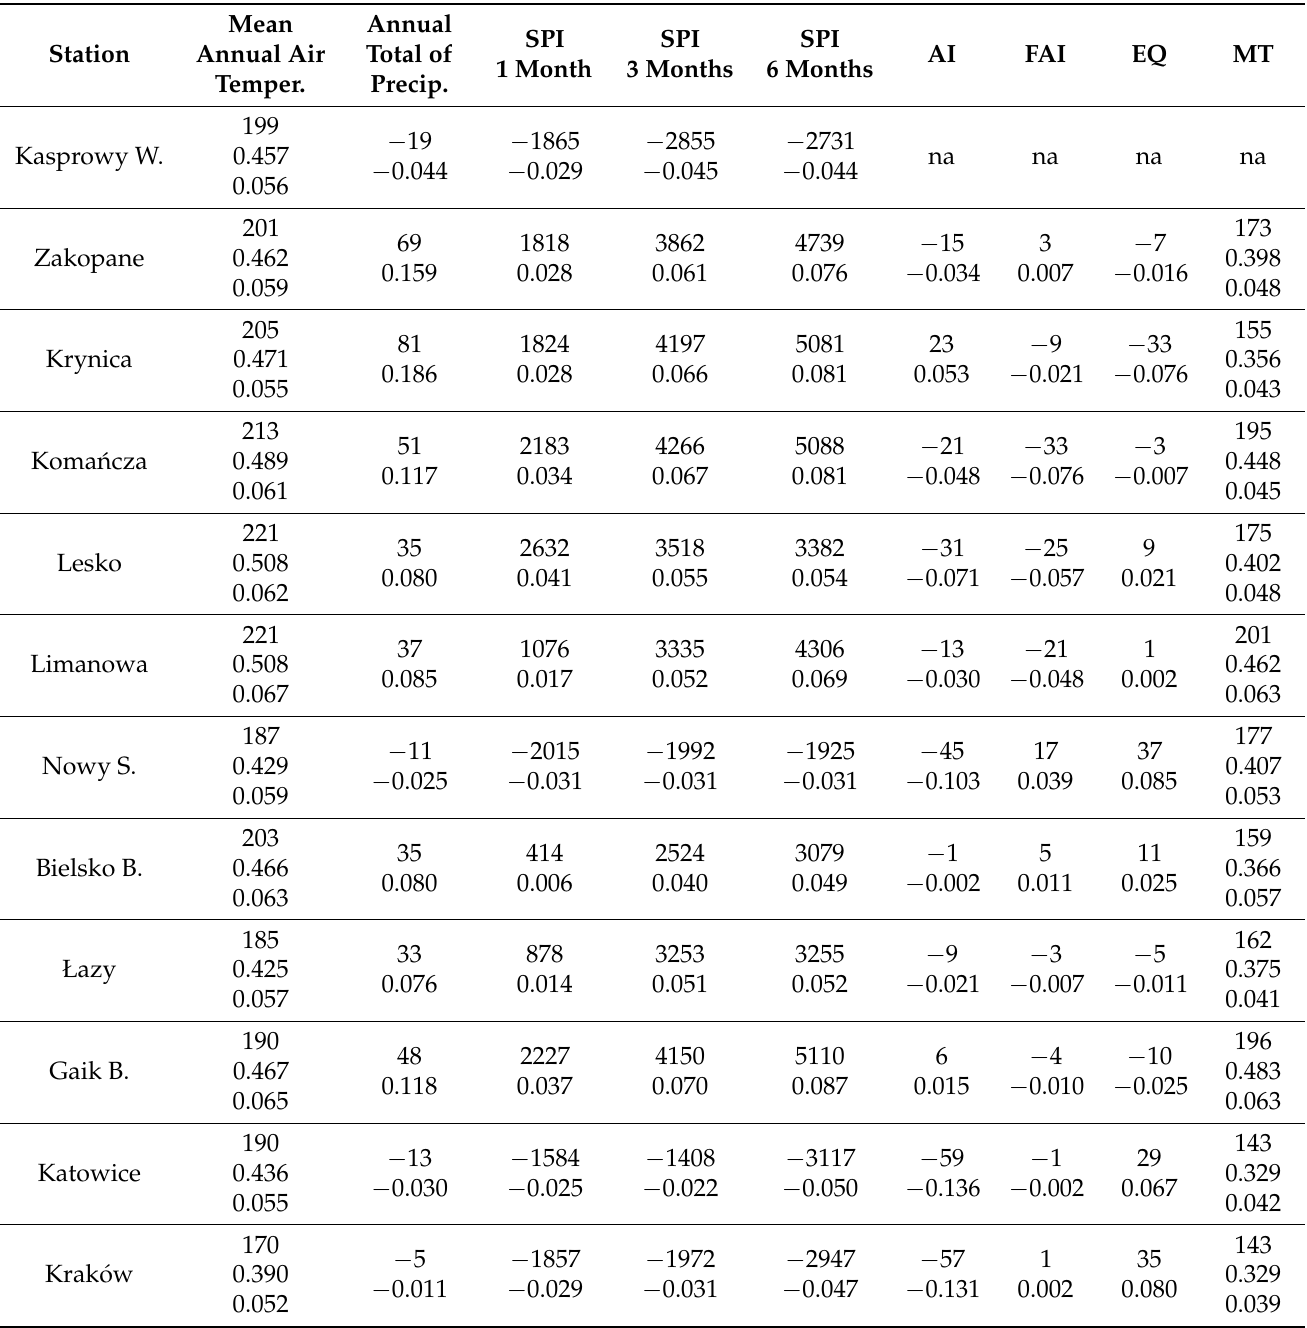
Table A1. Values of test statistics S (upper value) and tau (middle/bottom value) of the Mann–Kendall test for the series of mean annual air temperature, annual sums of precipitation, 1-, 3- and 6-monthly SPI, and annual values of AI, FAI, EQ and MT. For mean annual air temperature, the bottom value presents Sen’s slope value (provided only if the p -value calculated was lower than